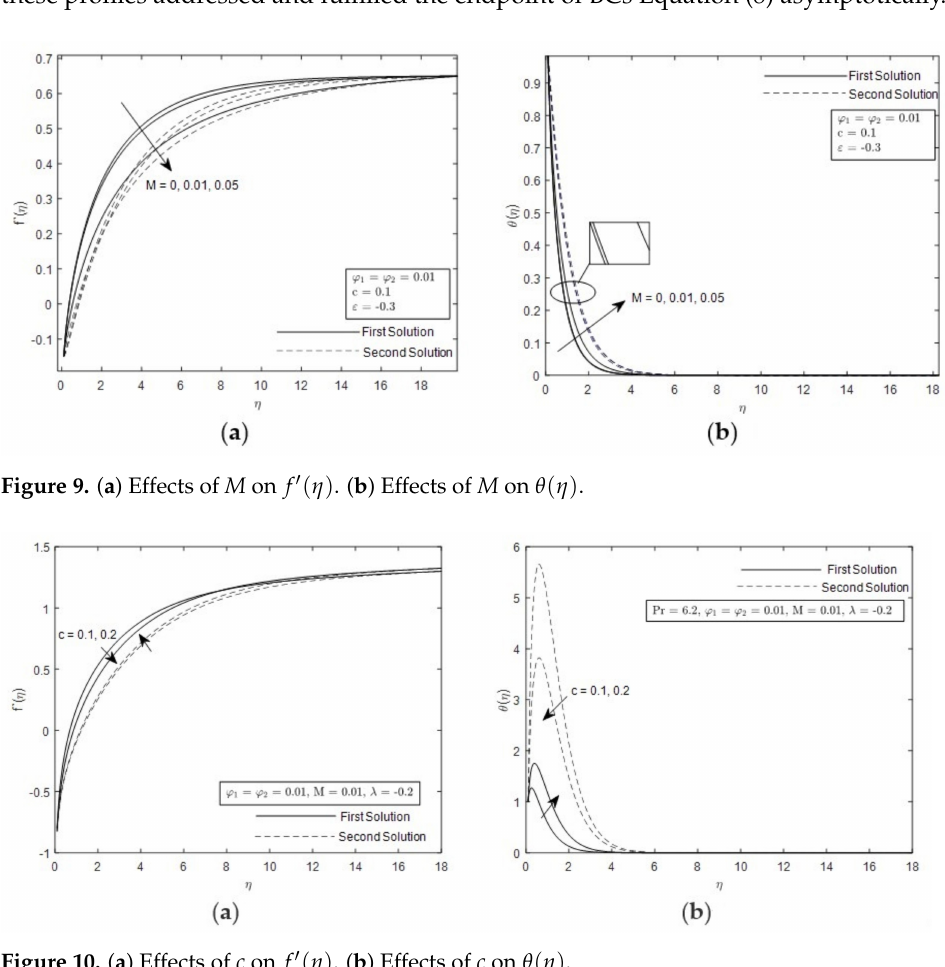
Figure 10. ( a ) Effects of c on f (cid:48) ( η ) . ( b ) Effects of c on θ ( η ) .